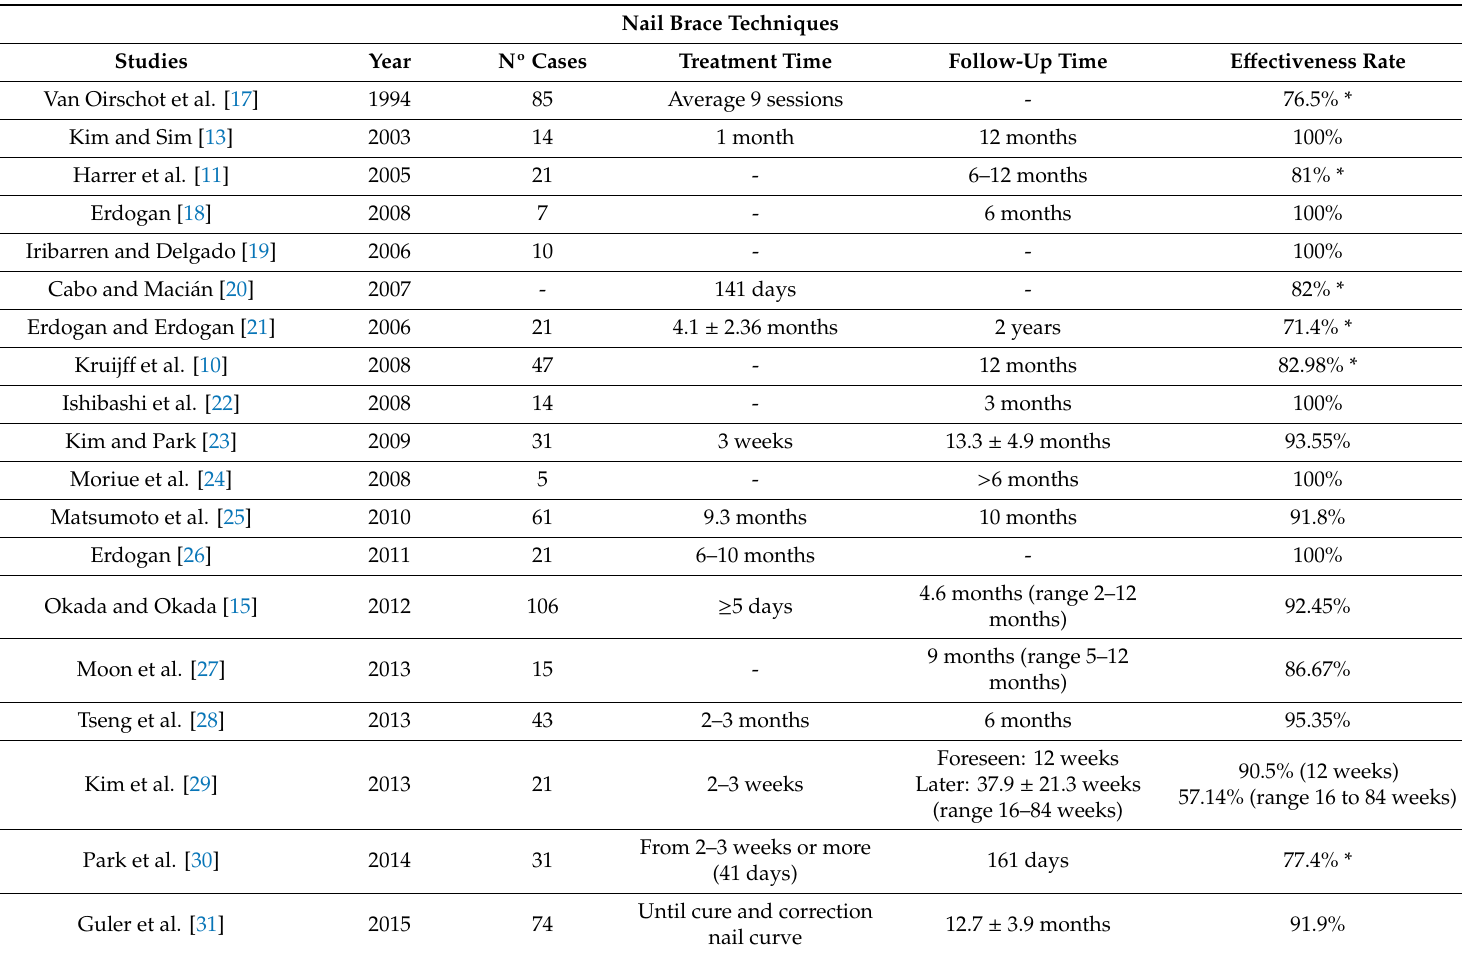
Table 3. Studies of the e ff ectiveness of other nail brace techniques and nail reeducation techniques. Nail Brace